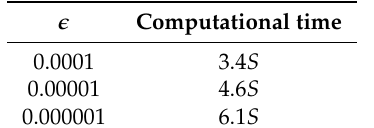
Table 2. Computational time.